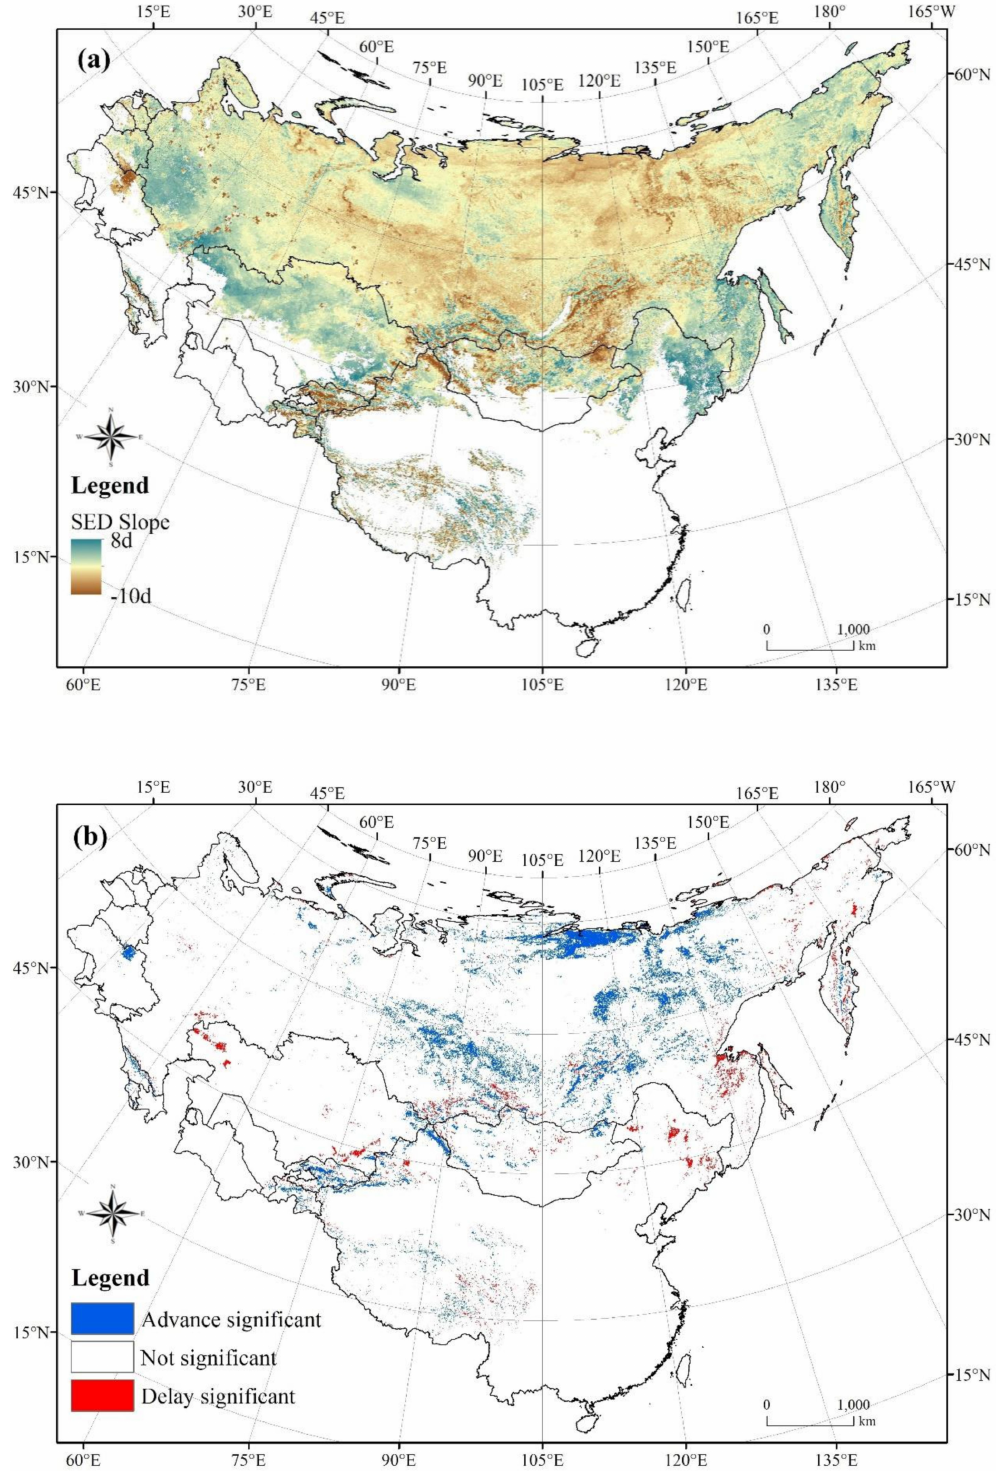
Figure 13. ( a ) The trend of SED, and ( b ) the significant test in the study area from 2000 to